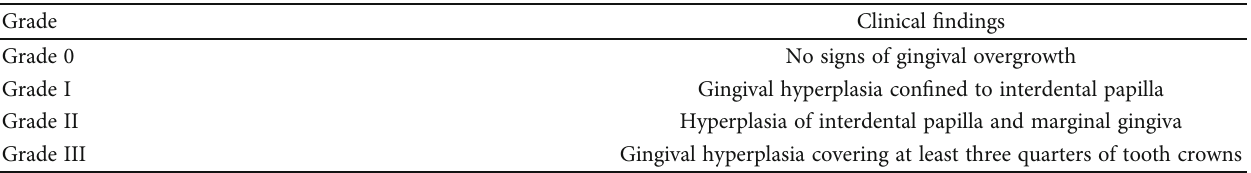
Table 1: Bokenkamp and Bohnhorst, 1994 classi fi